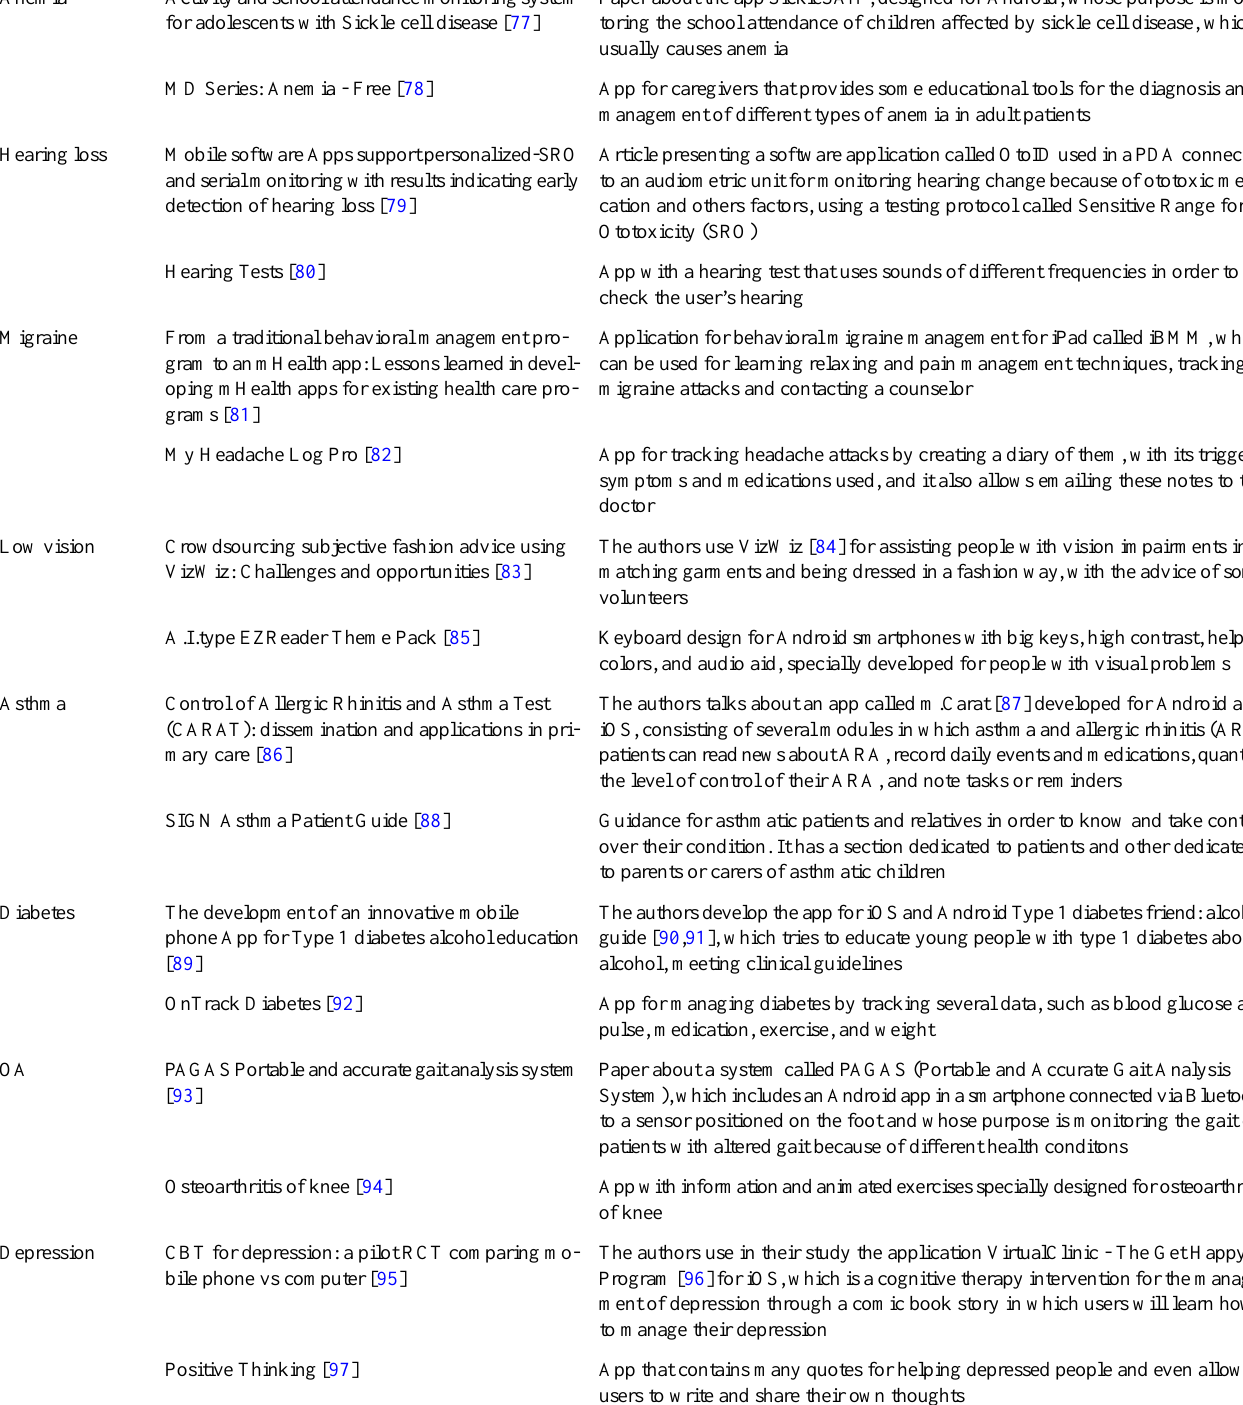
Table 3. Summary of the papers and commercial